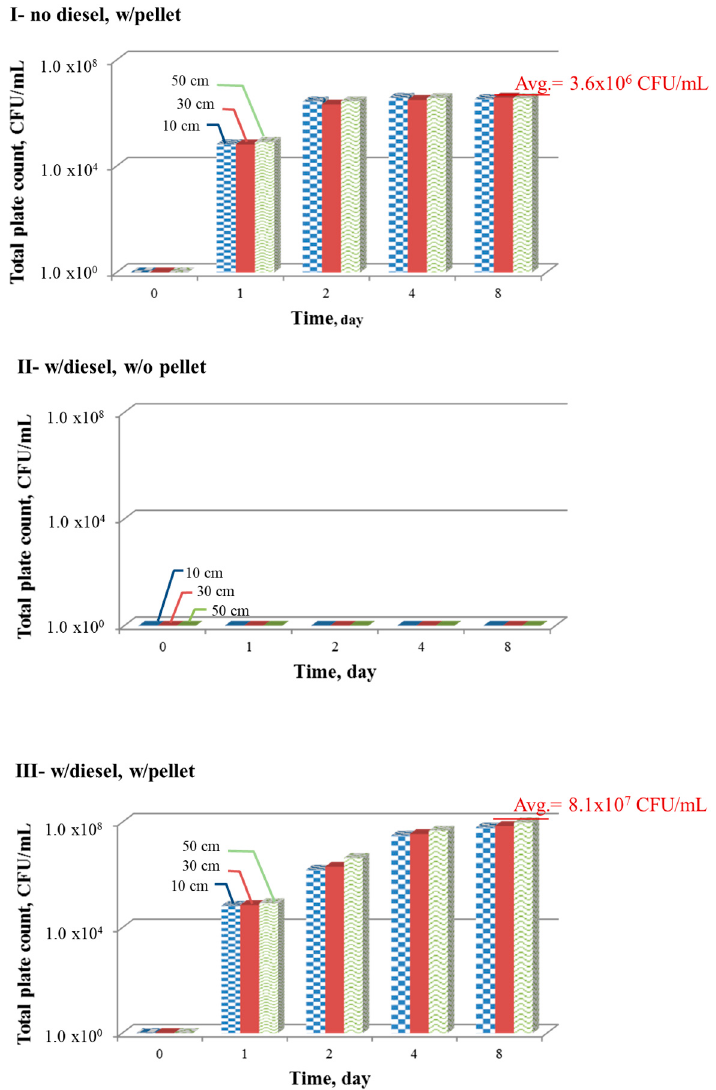
Figure 7. Microbial counts from Day 0 to 8 in the mimicked groundwater system. Table 4. Water quality at a depth of 10 cm during the first 8 days of TPH removal.